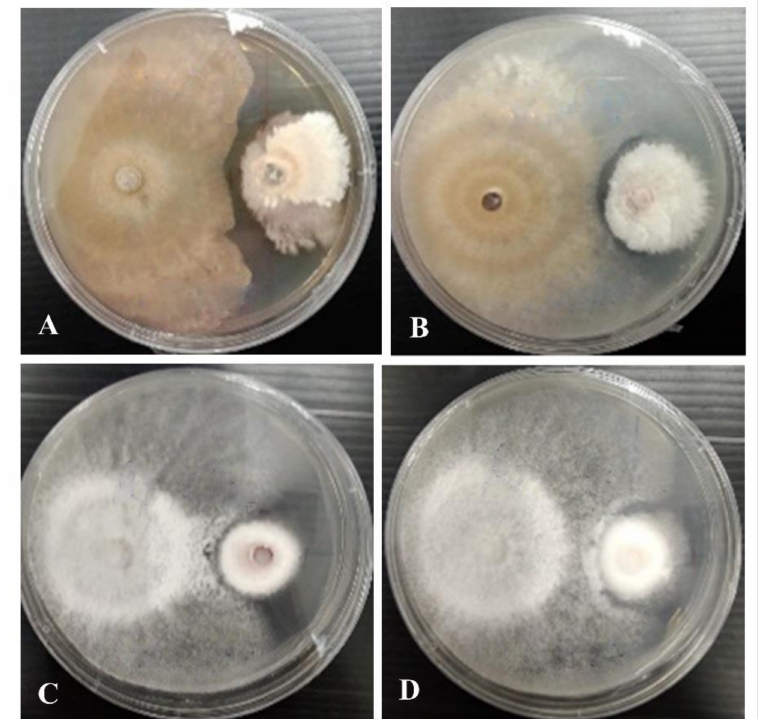
Figure 7. The antagonistic activity of Cytospora species (left colonies) against fungal pathogens (right colonies). ( A ) Cytospora shoreae (MFLUCC 21-0047) vs. Colletotrichum viniferum (MFLUCC 18-1179). ( B ) C. shoreae (MFLUCC 21-0048) vs. Co. viniferum (MFLUCC 18-1179). ( C ) C. phitsanulokensis (MFLUCC 21-0046) vs. Co. viniferum (MFLUCC 18-1179). ( D ) C. phitsanulokensis (MFLUCC 21-0046) vs. Fusarium sambucinum (MFLUCC